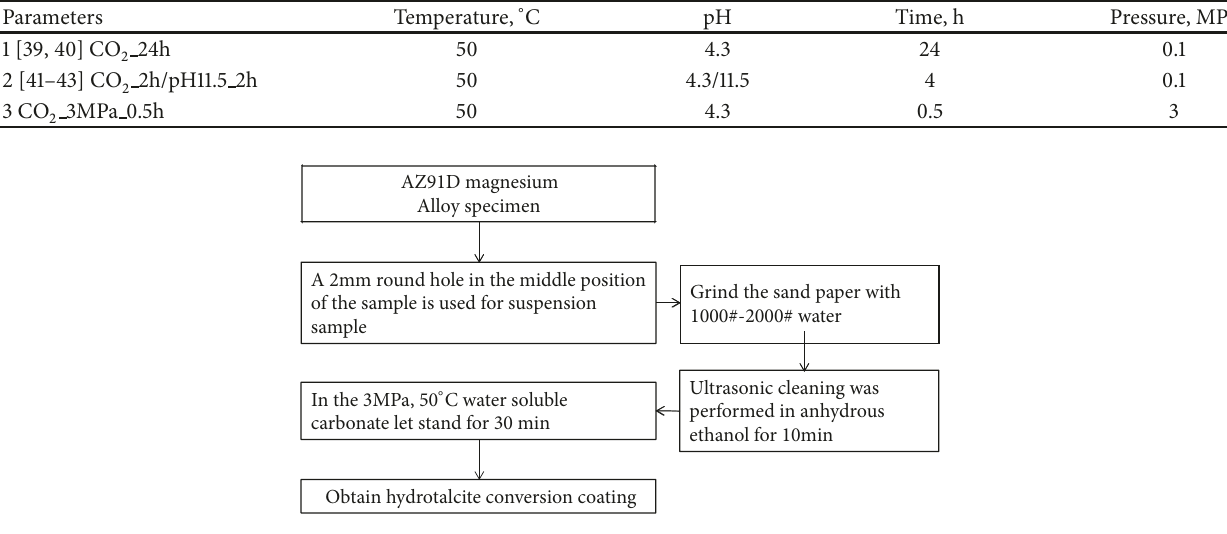
Figure 1: Operations for the preparation of conversion coating with CO 2 pressurization